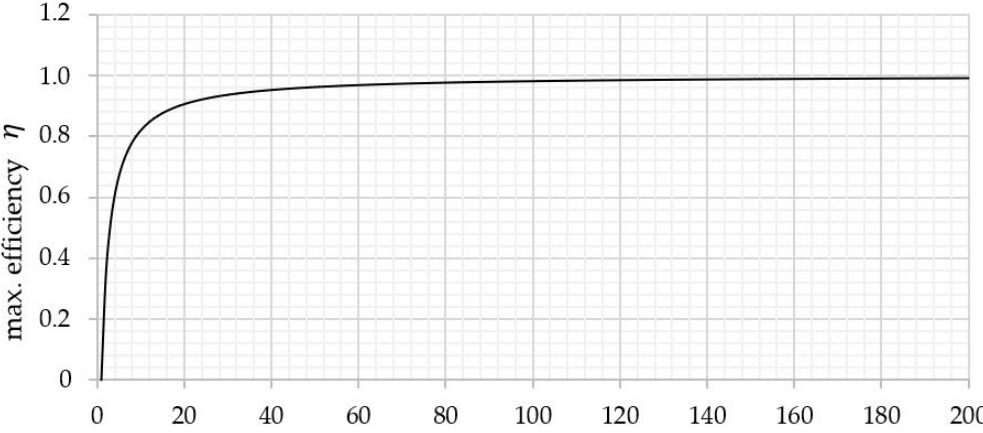
Figure 7. Quality curve: efficiency vs. transmission.